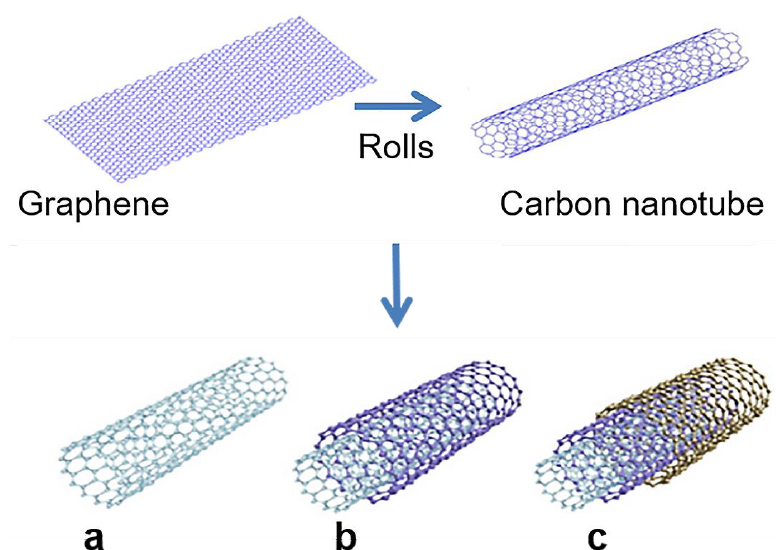
Figure 4. Diagram depicting carbon nanotube structures (CNTs) [38,39]: ( a ) single-walled CNTs; ( b ) double-walled CNTs; ( c ) multi-walled CNTs.